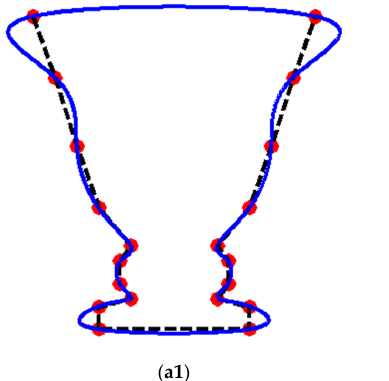
Figure 14. ( a1 , b1 ) under periodic end conditions, the default RQTS. ( a2 , b2 ) RQTS among local Figure 14. ( a1 ) and ( b1 ) under periodic end conditions, the default RQTS. ( a2 ) and ( b2 ) RQTS among local tension, with 𝜌 (cid:3036) (cid:3404) 𝜎 (cid:3036) (cid:3404) 100 at the essential portion of the shape. tension, with ρ i = σ i = 100 at the essential portion of the shape.